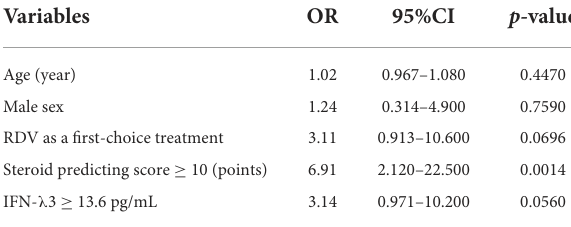
TABLE 4 Multivariate logistic regression analysis of factors accounting for conditions requiring steroid